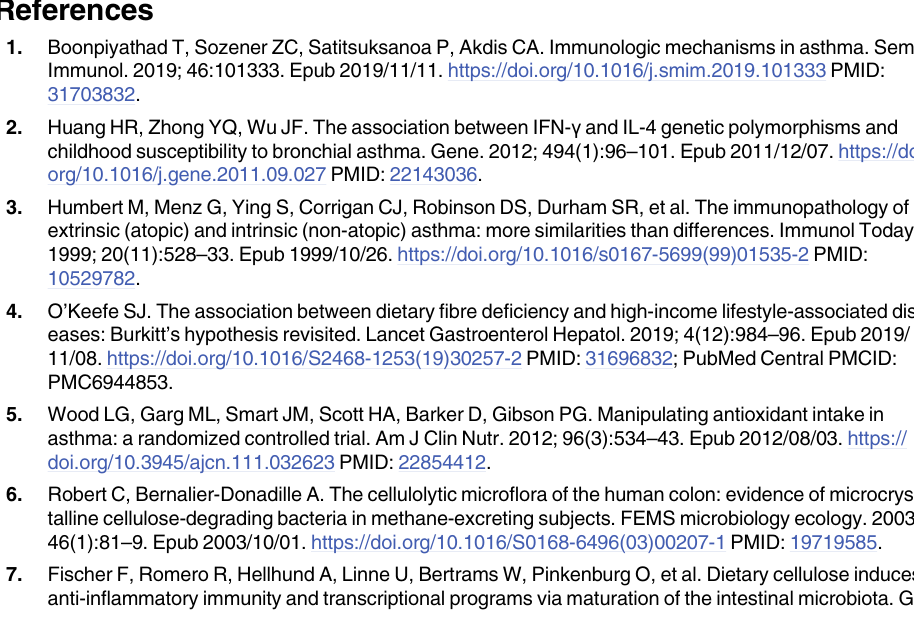
S1 Table. Formula of high cellulose feed. S2 Table. Formula of regular